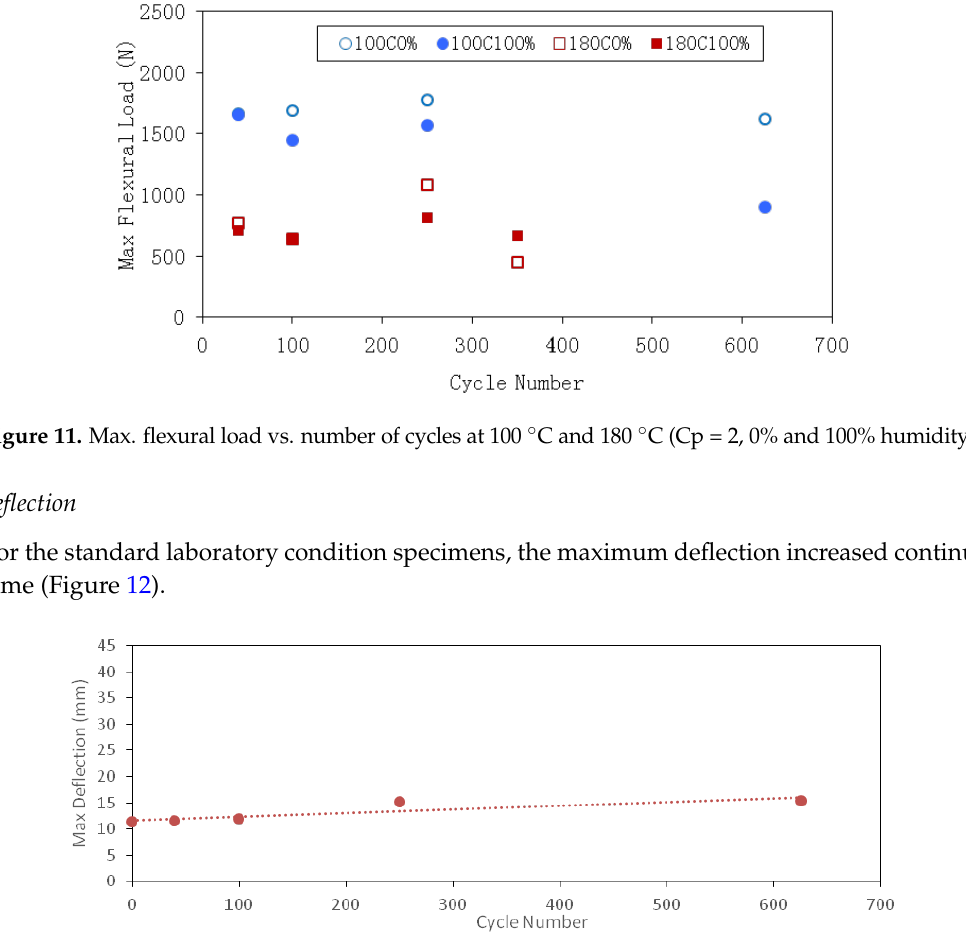
Figure 12. Max. deflection vs. number of cycles for the control specimens. Each cycle is equivalent to 2 h.